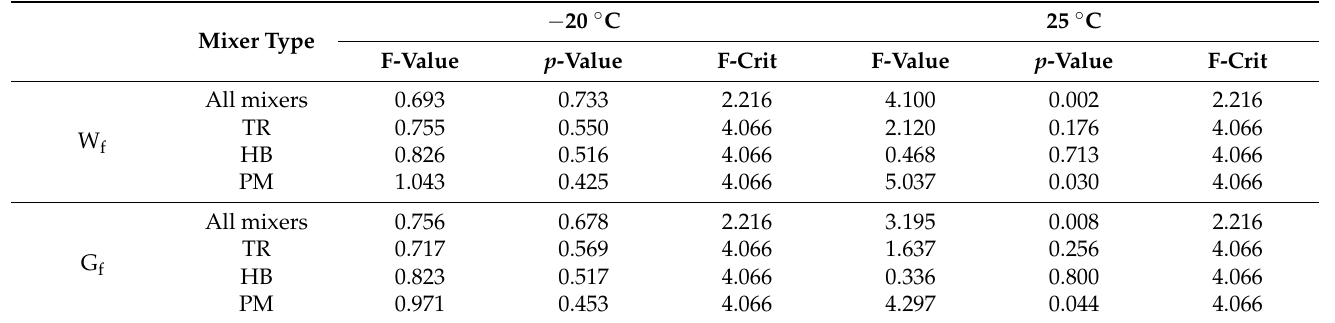
Table 12. One-way ANOVA of W f and G f results at − 20 and 25 ◦ C (significance level =